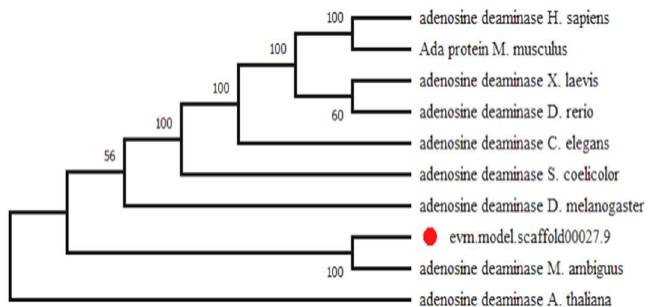
Figure 1. Phylogenetic analysis of ADA using MEGA6. The ADA from the model organism was identified by BLASTp and aligned using the neighbor-joining method. The sequences are Homo sapiens (NP_000013.2), Mus musculus (AAH02075.1), Xenopus laevis (NP_001085740.1), Danio rerio (AAH76532.1), Caenorhabditis elegans (NP_872091.1), Streptomyces coelicolor (CAC33066.1), Drosophila melanogaster (NP_649866.1), M. circinelloides , Mucor ambiguus (GAN00815.1), and Arabidopsis thaliana (NP_192397.2) .